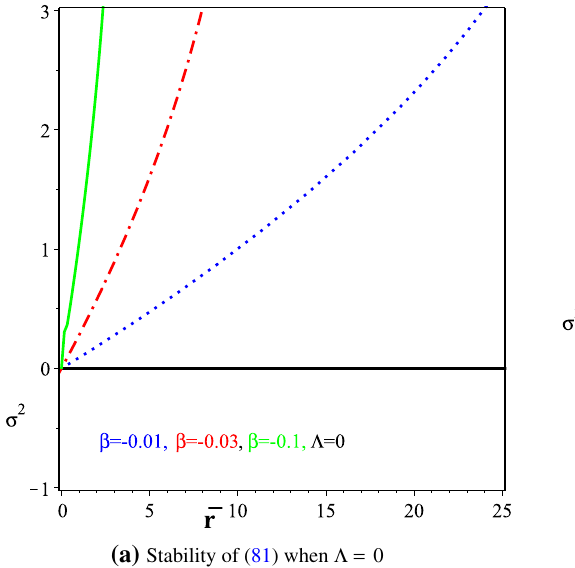
( a ) Stability of (81) when Λ = 0 (b) Stability of (81) when Λ ≠ 0 Fig. 14 Schematic plot of Eq. (81), namely σ 2 versus the coordinate r Equation (78) can be rewritten as d 2 ξ